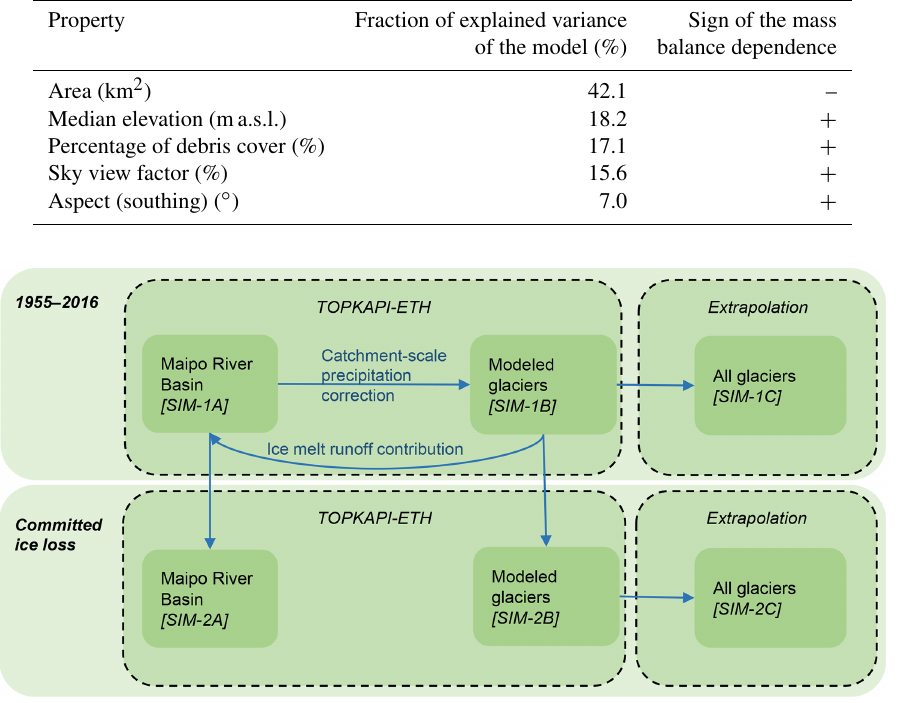
Figure 5. Organization of the simulations. The two main boxes indicate the time period of the simulations (1955–2016 and committed ice loss scenario), the boxes with a dashed outline indicate the method used (TOPKAPI-ETH or extrapolation), and the smallest boxes indicate the spatial domain (Maipo River basin, modeled glaciers, and all glaciers). The arrows indicate outputs that are used in other methods or domains. The codes in brackets (e.g., SIM-1A) correspond to the simulation codes defined in Table